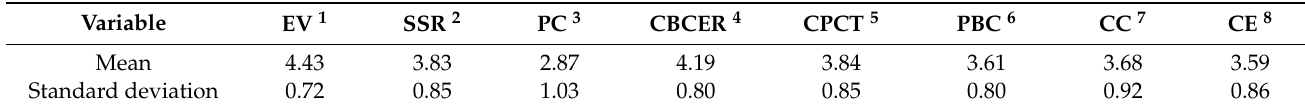
Table 3. Descriptive statistics of other